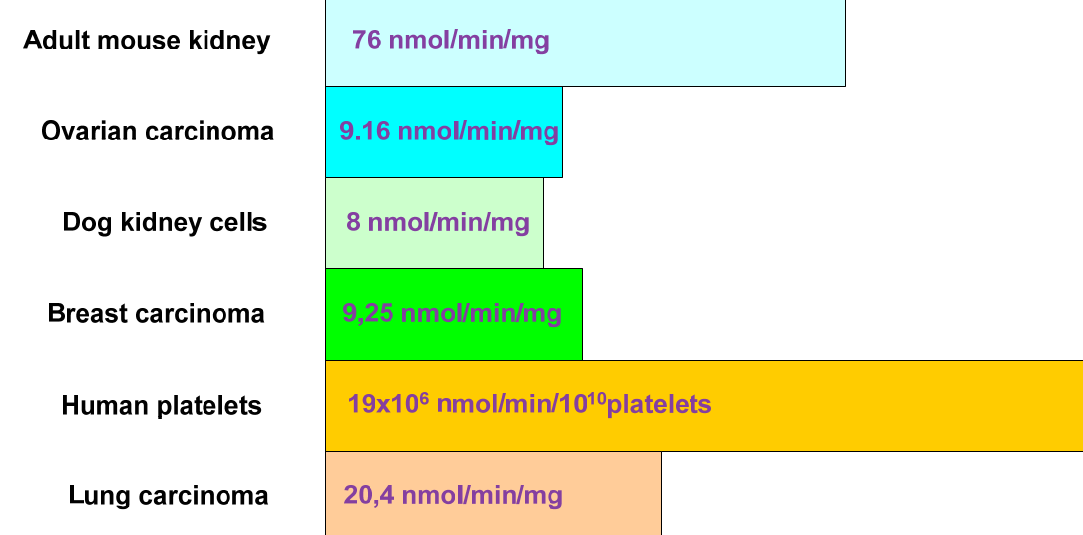
Figure 2. Glycolytic ATP contribution in tumour and normal cells–Oxidative ATP production (based on Zu and Guppy [38]).